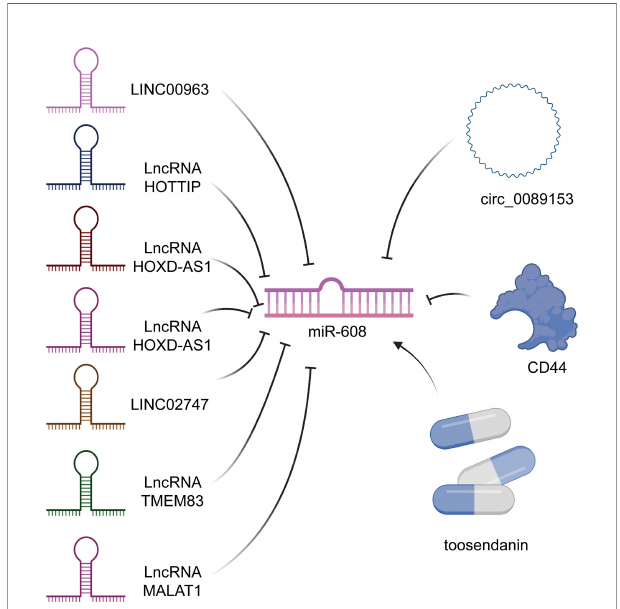
FIGURE 1 | Upstream targets of miR-608. Not only many lncRNAs can regulate the level of miR-608, but also some circRNAs and drugs, such as toosendanin, can also play the role of regulator of miR-608.